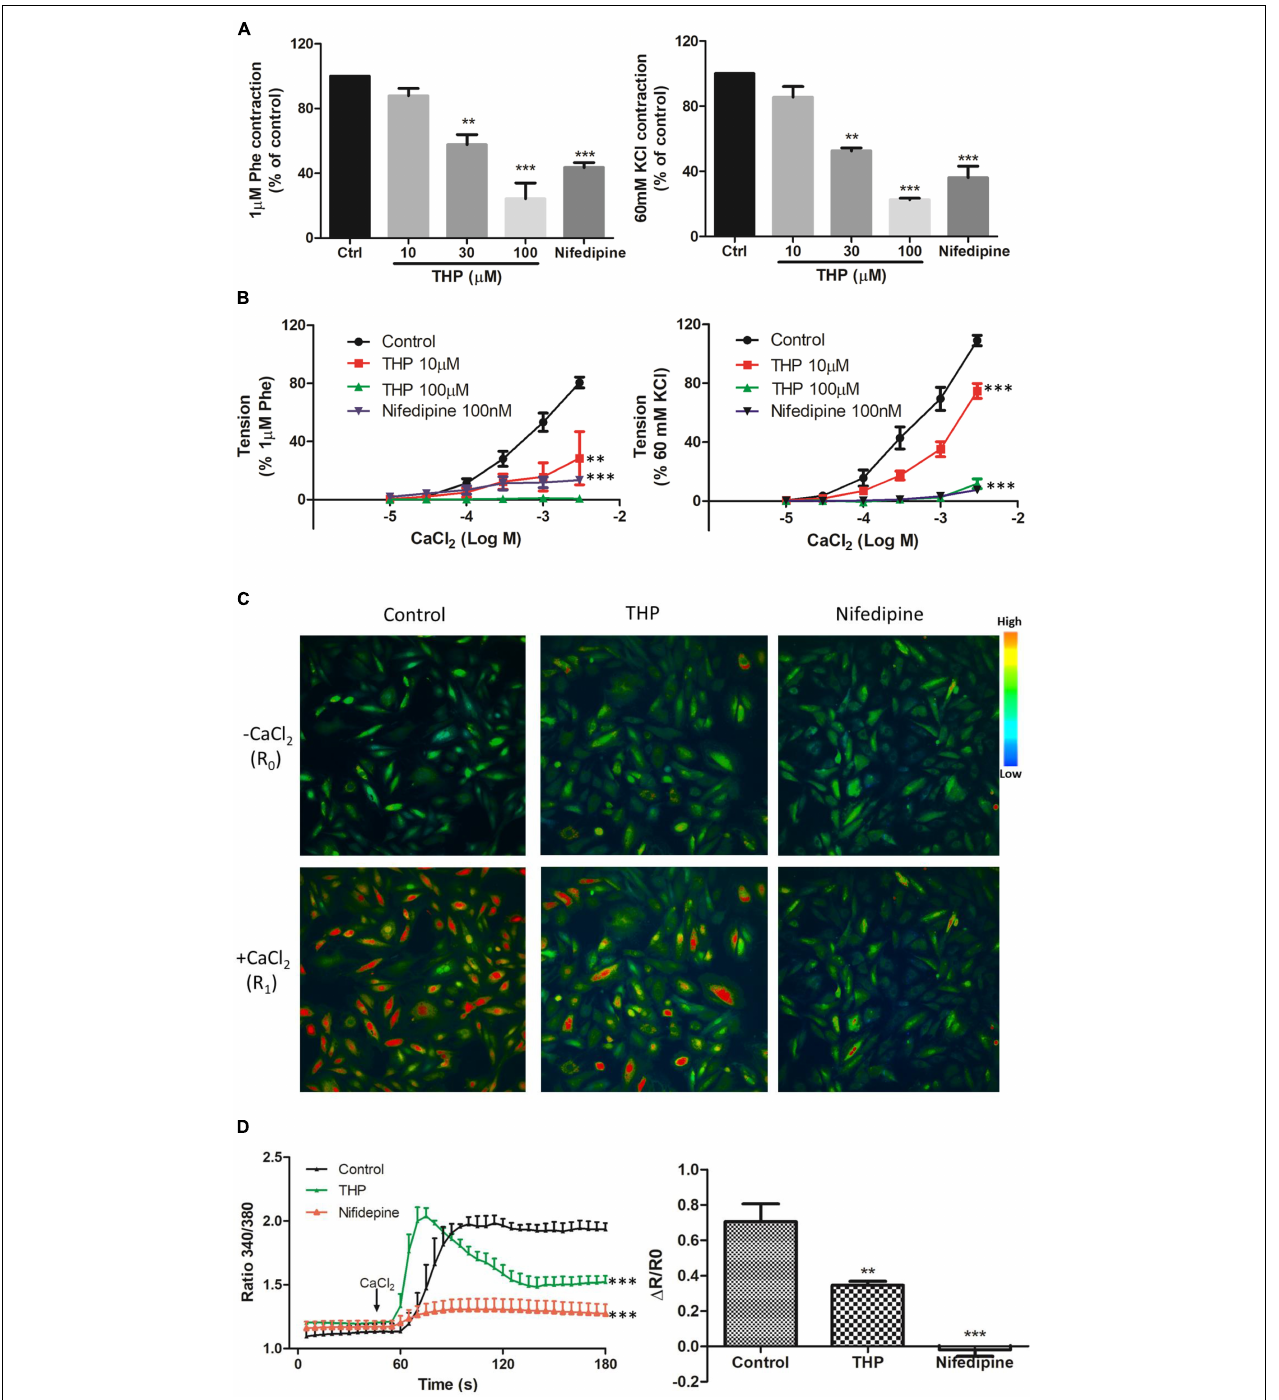
FIGURE 3 | Tetrahydropalmatine-induced vascular relaxation was dependent on inhibition of Ca 2 + influx. (A) Pre-treatment THP (10, 30, and 100 µ M) inhibited KCl (60 mM) or Phe (1 µ M) induced contraction of aorta in a concentration dependent manner. (B) Concentration-response curves showed pre-treatment THP (10 and 100 µ M) inhibited CaCl 2 (0.01–3 mM) induced contraction of aorta in Ca 2 + -free Krebs solution containing KCl (60 mM) or Phe (1 µ M). (C) Representative images of calcium imaging. In A7r5 cells, pre-treatment THP (100 µ M) or nifedipine (100 nM) inhibited the Ca 2 + influx triggered by the addition of CaCl 2 (2.5 mM) in Ca 2 + free Krebs solution containing KCl (60 mM). (D) Time-course response and summarized graph of ratio 340 nm/380 nm (R). The change of ratio 340 nm/380 nm value ( (cid:49) R) was calculated as ratio 340 nm/380 nm value after the addition of CaCl 2 for 2 min (R 1 ) minus ratio 340 nm/380 nm value before the addition of CaCl 2 (R 0 ). Nifedipine served as positive control. Vascular contraction presented as percentage of the evoked tone. Results were means ± SEM of more than three experiments. ∗∗ P < 0.01, ∗∗∗ P < 0.001 versus control group.